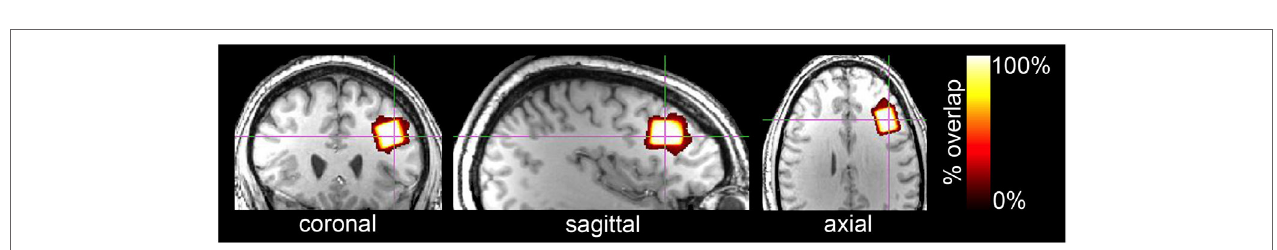
FigUre 2 | The experimental tasks are depicted. Left panel: the continuous passive visual fixation task consisted of instructions (“Rest”; 2s) and static fixation cross (centered on-screen; 238s). Right panel : the letter 2-back task consisted of two phases: variance minimization and alternating periods of letter 2-back interleaved with periods of passive visual fixation. The variance minimization phase consisted of a flashing grayscale checkerboard (centered on-screen; 3Hz) presented for 208s. Previous research in our laboratory demonstrated that the flashing checkerboard minimized glutamate variance better than alternative approaches (36). The working memory task consisted of seven interleaved repetitions of passive visual fixation [32s; 2s of instructions (“Rest”), 30s of static fixation cross centered on-screen] and letter 2-back [64s; 4s of instructions (“2-back”), 20 capitalized letters presented serially 3s/letter (60s total); each letter was presented on screen for 500ms followed by 2,500ms of blank screen].